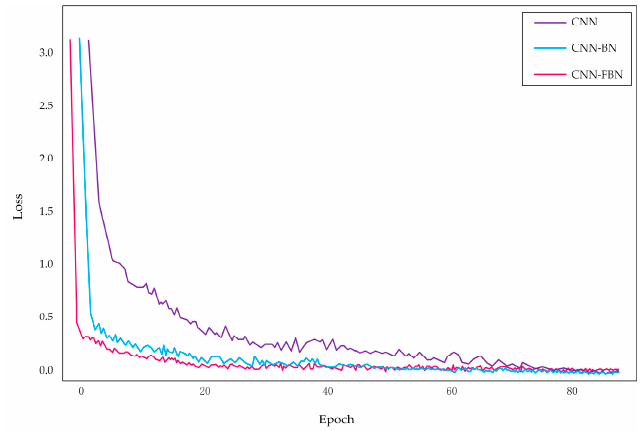
Figure 10. The number of epoch affects the loss value.